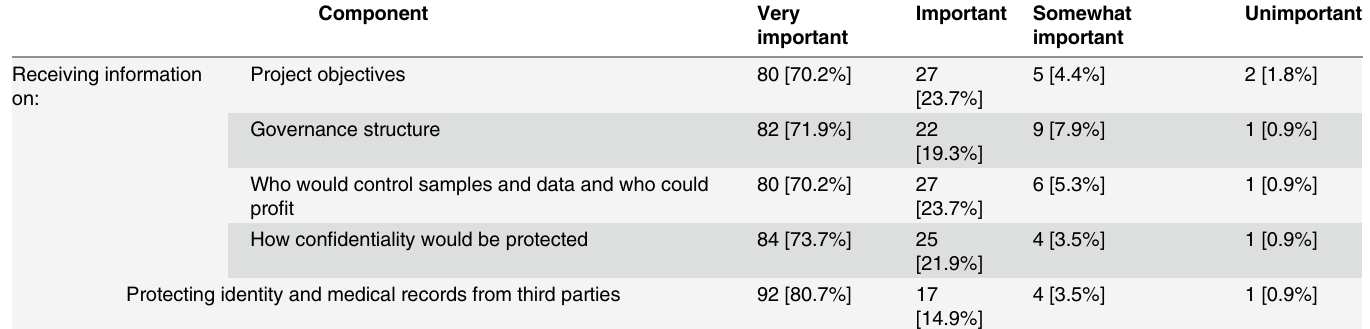
Table 3. Importance of Receiving Clear and Specific Information on Key Consent Components and of Protecting Participant Confidentiality.